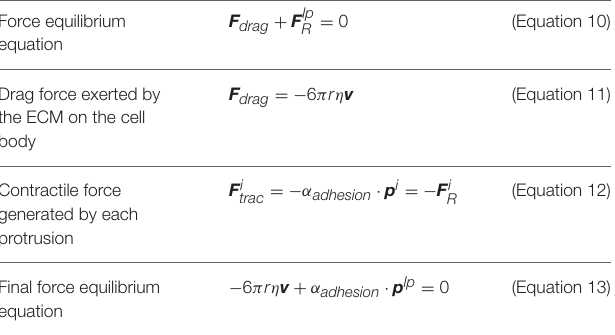
TABLE 3 | Equations associated with the body